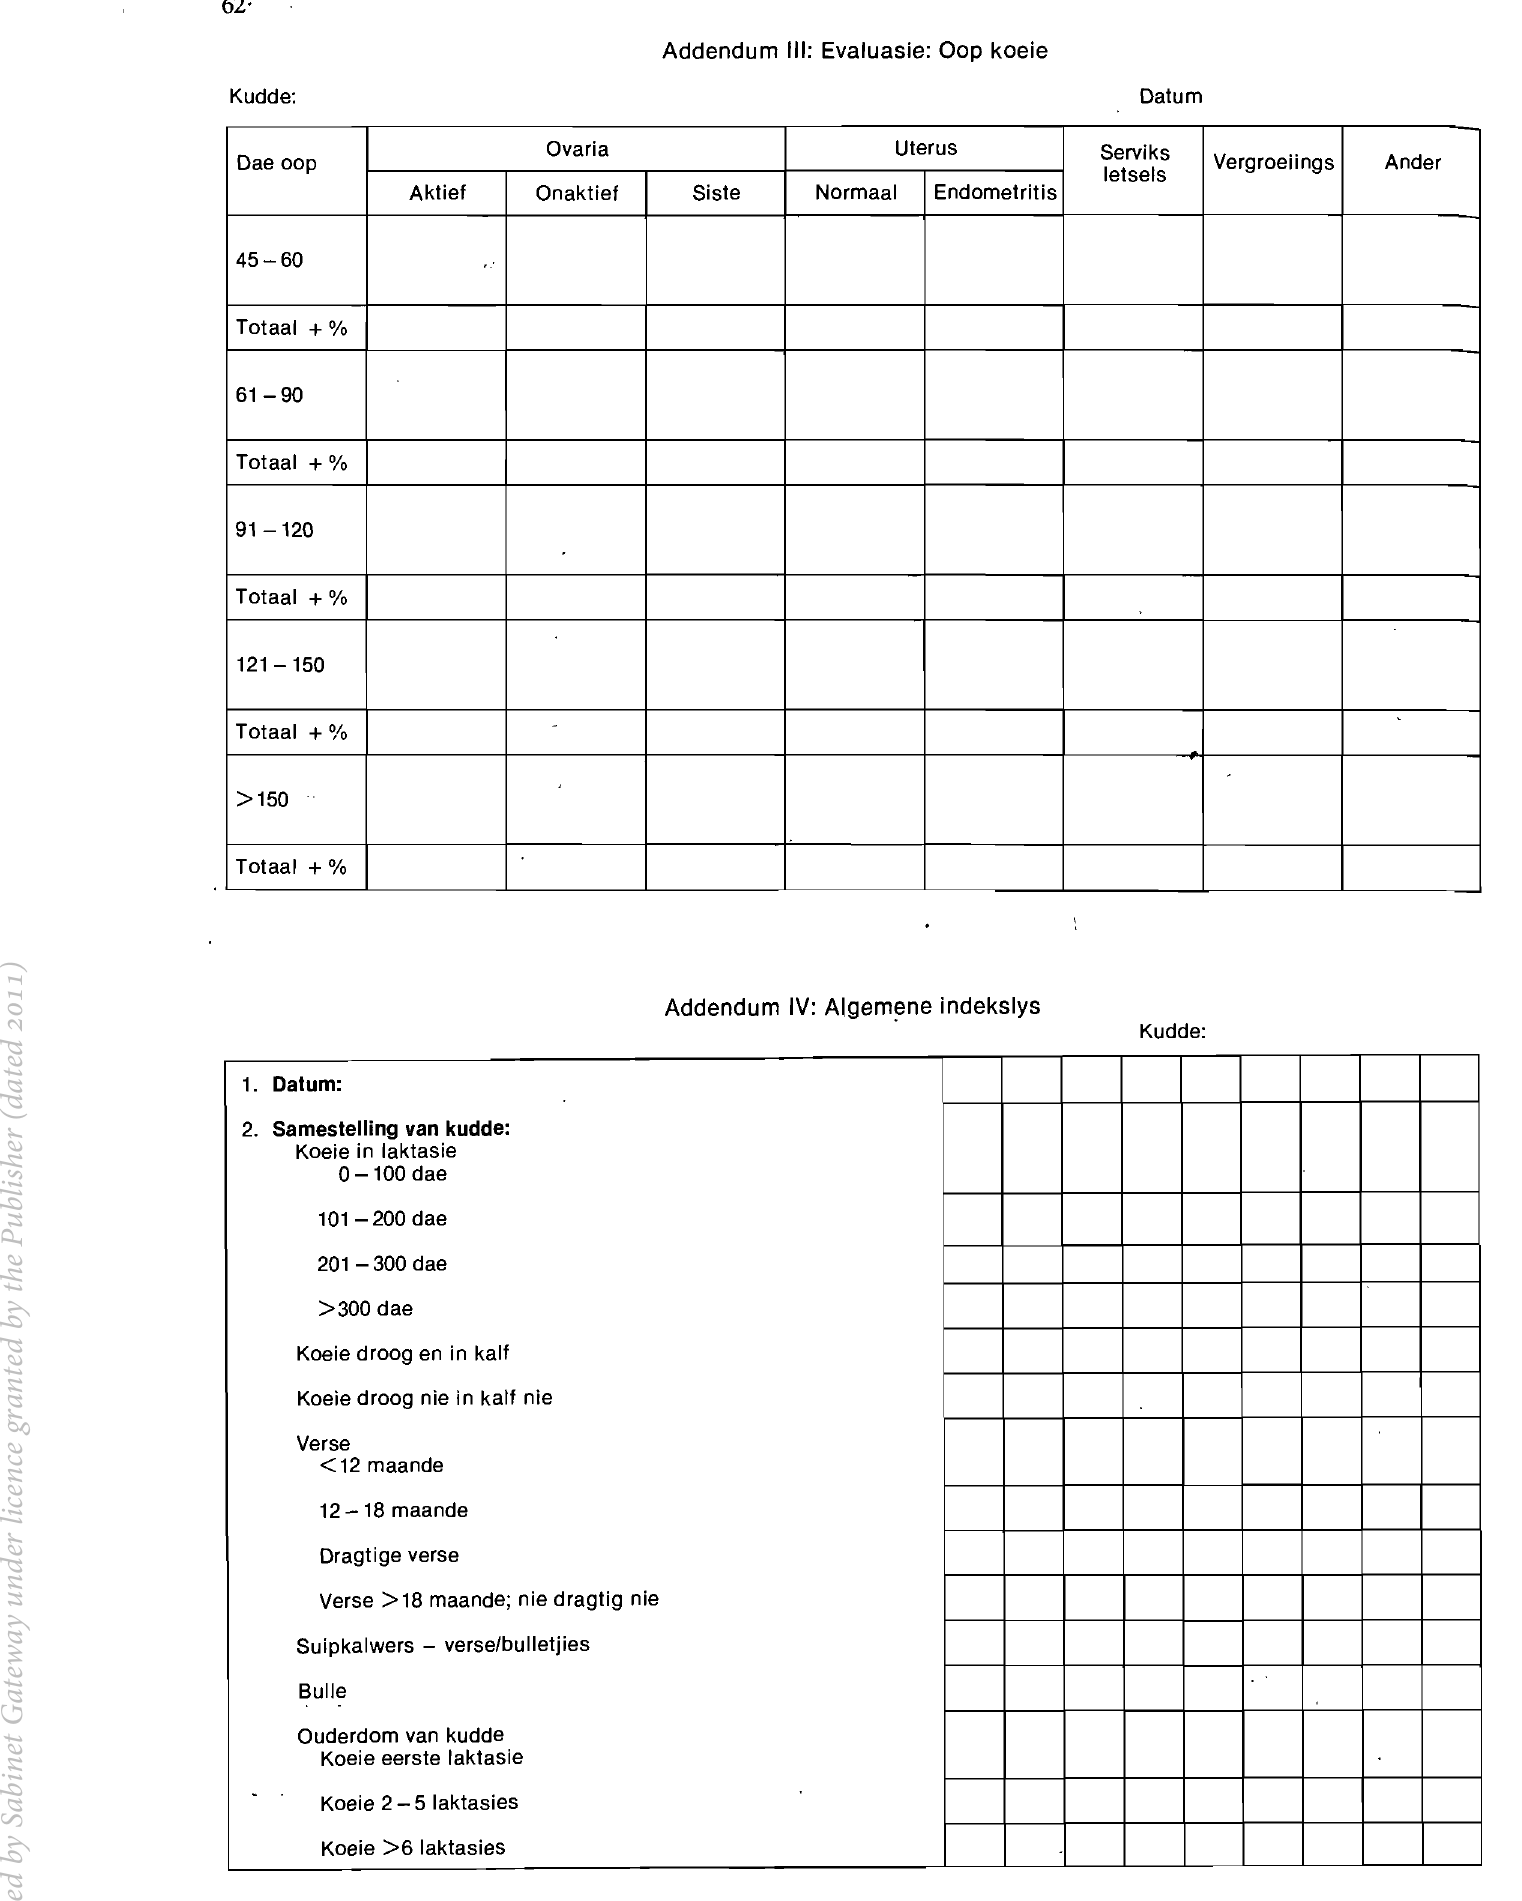
Suipkalwers - verse/bulletjies Bulle Ouderdom van kudde Koeie eerste laktasie - Koeie 2 - 5 laktasies Koeie >6 laktasies